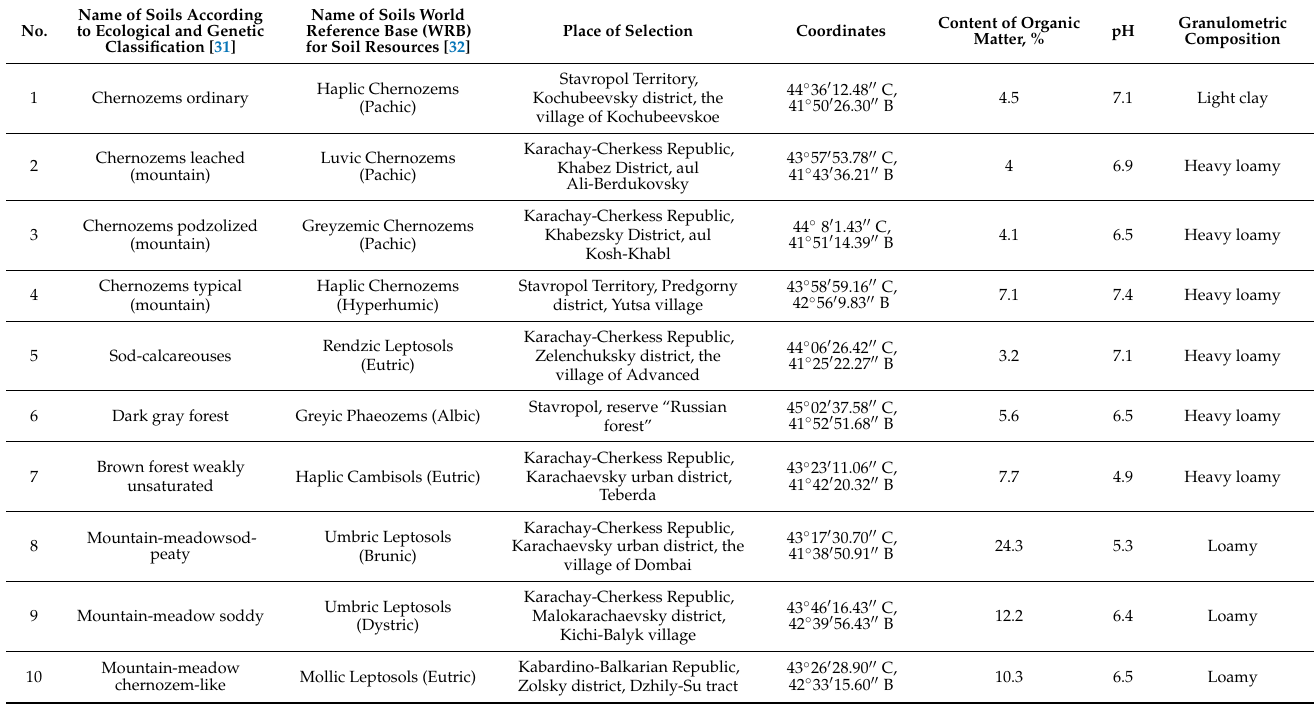
Table 1. Sampling locations and ecological and genetic characteristics of studied